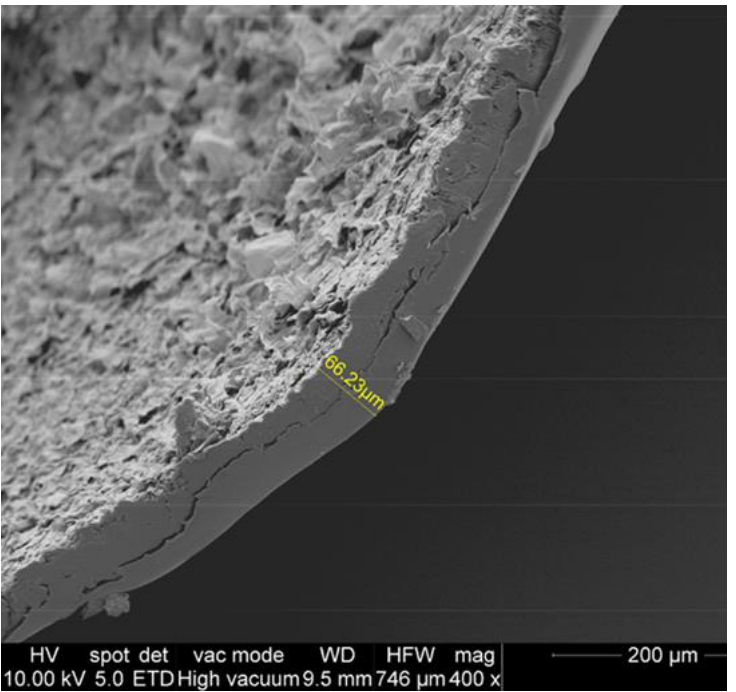
Figure 2 . Environmental scanning electronic microscope (ESEM) picture showing the thickness (in yellow) of the double coating layer of chitosan added with Ferulago campestris essential oil utilized for the protection of the bean seeds.